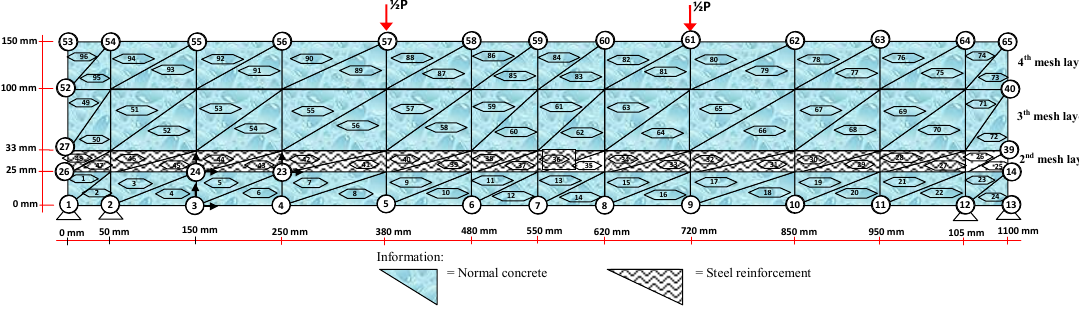
Figure 3. Discretization of the triangular element on the bamboo reinforced concrete (BRC) beam.